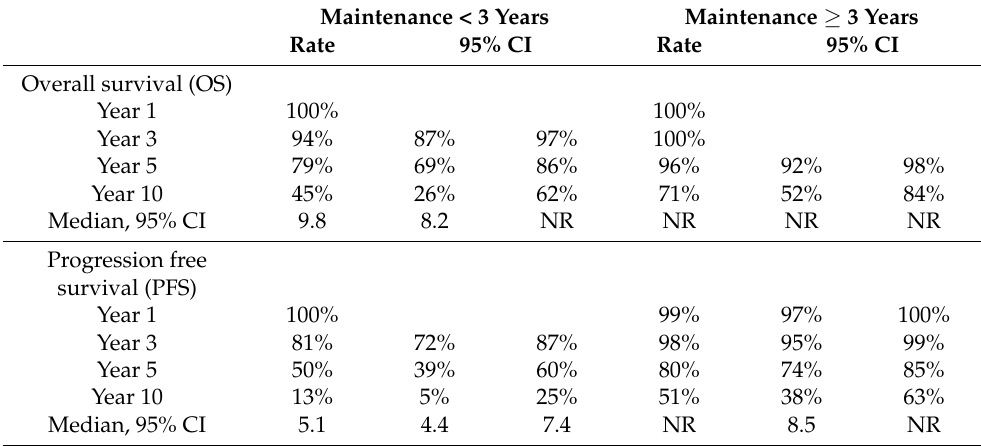
Table 4. Progression free and overall